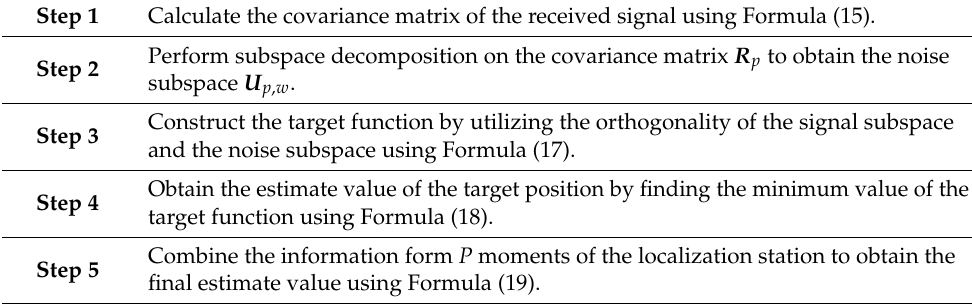
Table 2. The proposed algorithm